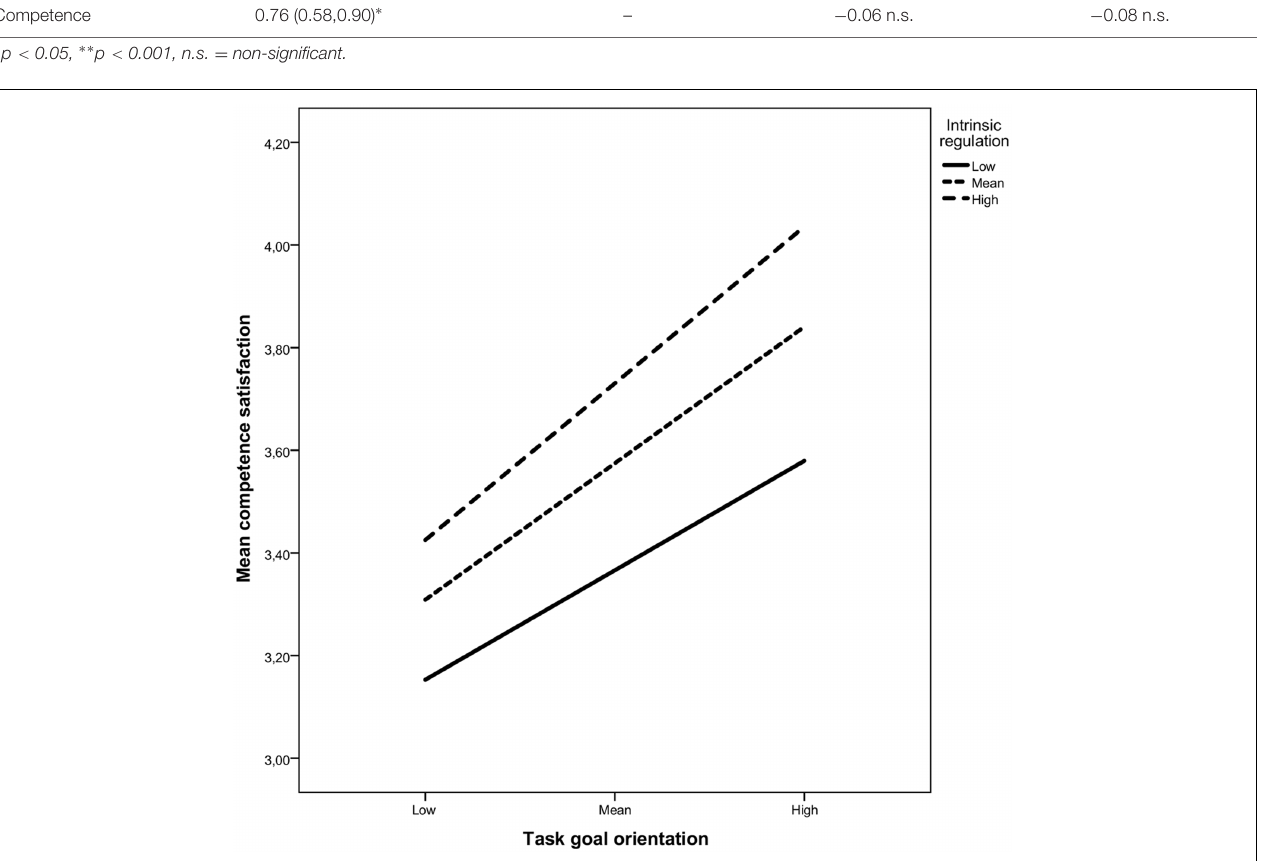
FIGURE 2 | Moderating role of intrinsic regulation on the relationship between task goal orientation and competence need satisfaction.